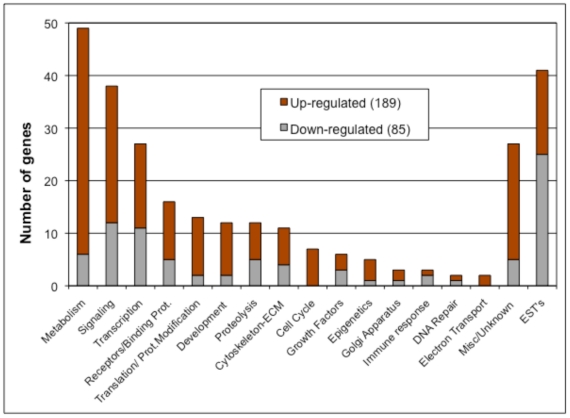
Number of genes differentially expressed in rat P0-ovary upon AMH treatment and their distribution among main functional categories.Dark-grey - up-regulated (189 genes) and light-grey - down-regulated genes (85 genes).